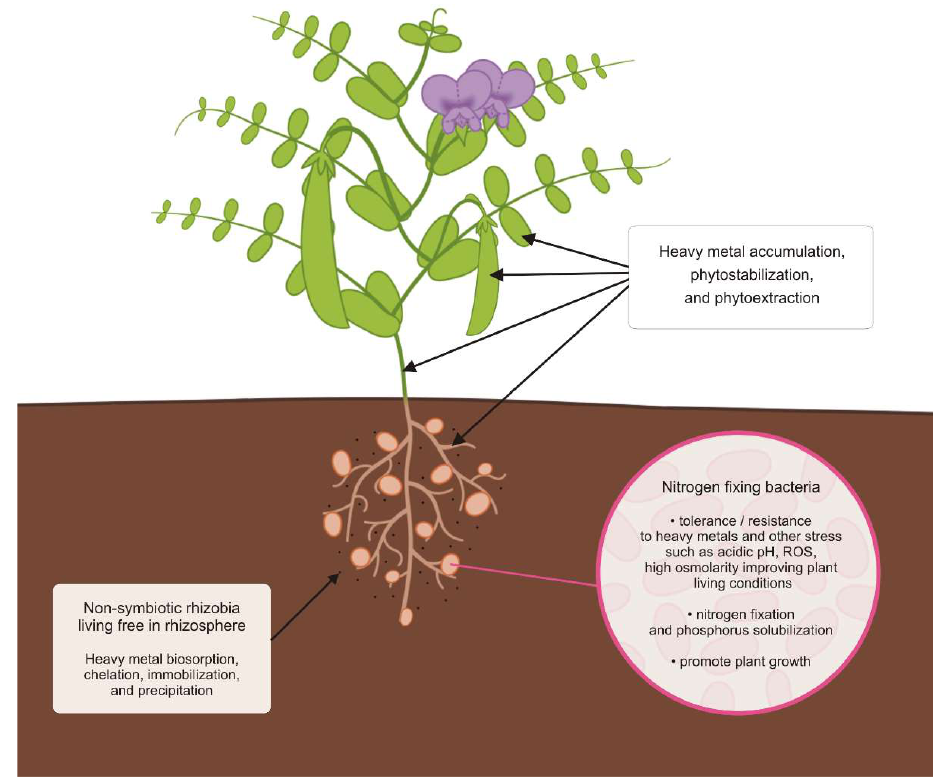
Figure 1. Legume–rhizobium symbiosis involved in the biorhizoremediation process for heavy metal removal.